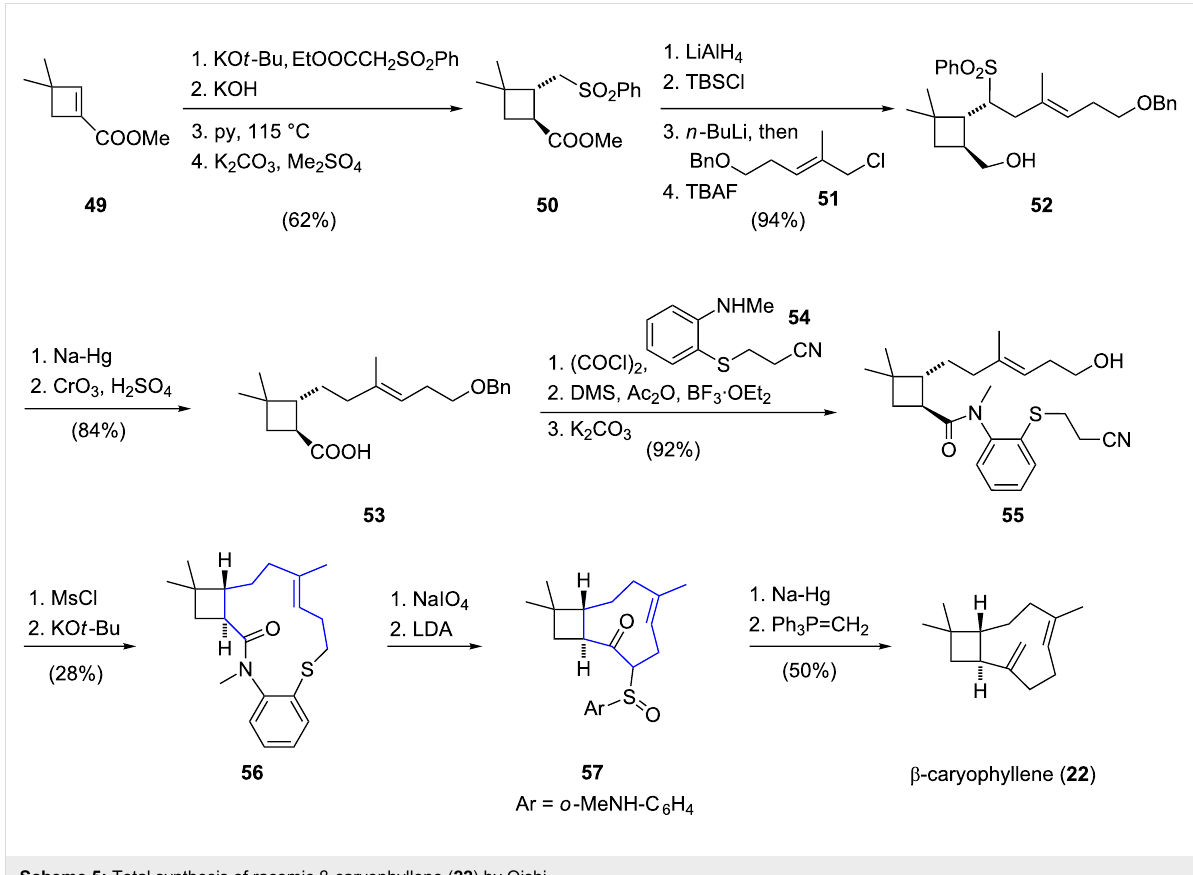
Scheme 5: Total synthesis of racemic β -caryophyllene ( 22 ) by